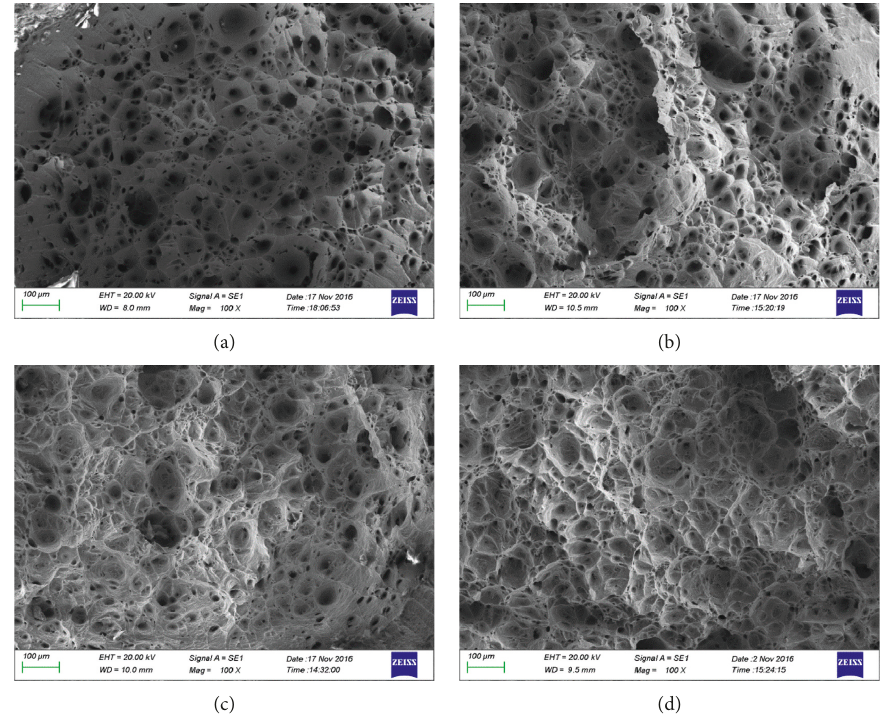
Figure 12: The fracture morphology of different notched samples at a tensile temperature of 850 ° C: (a) 6mm, (b) 4mm, (c) 2mm, and (d)